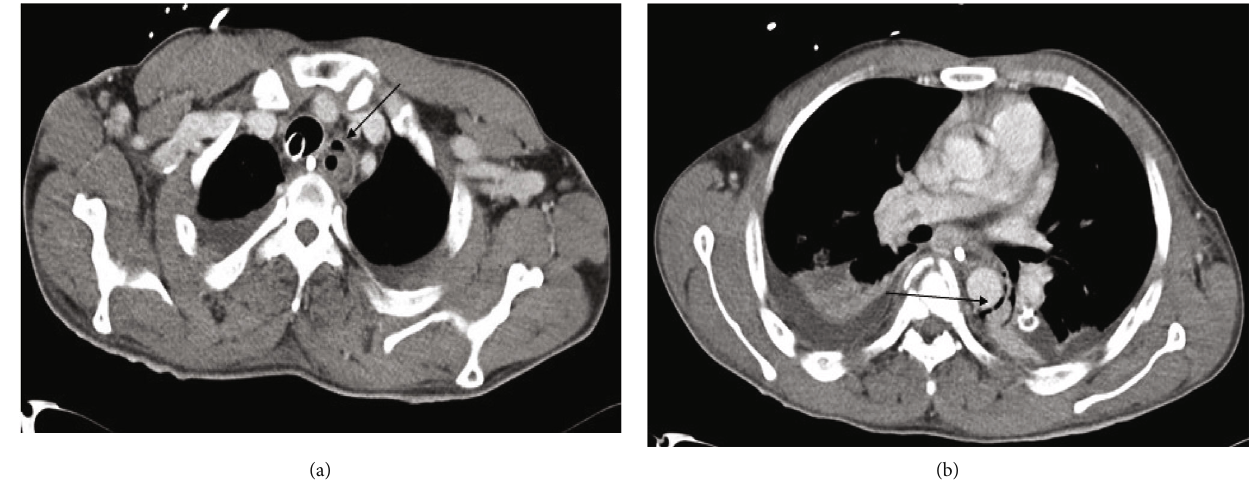
Figure 3: Chest CT scan shows (a) air leak around the esophagus and (b) pneumomediastinum